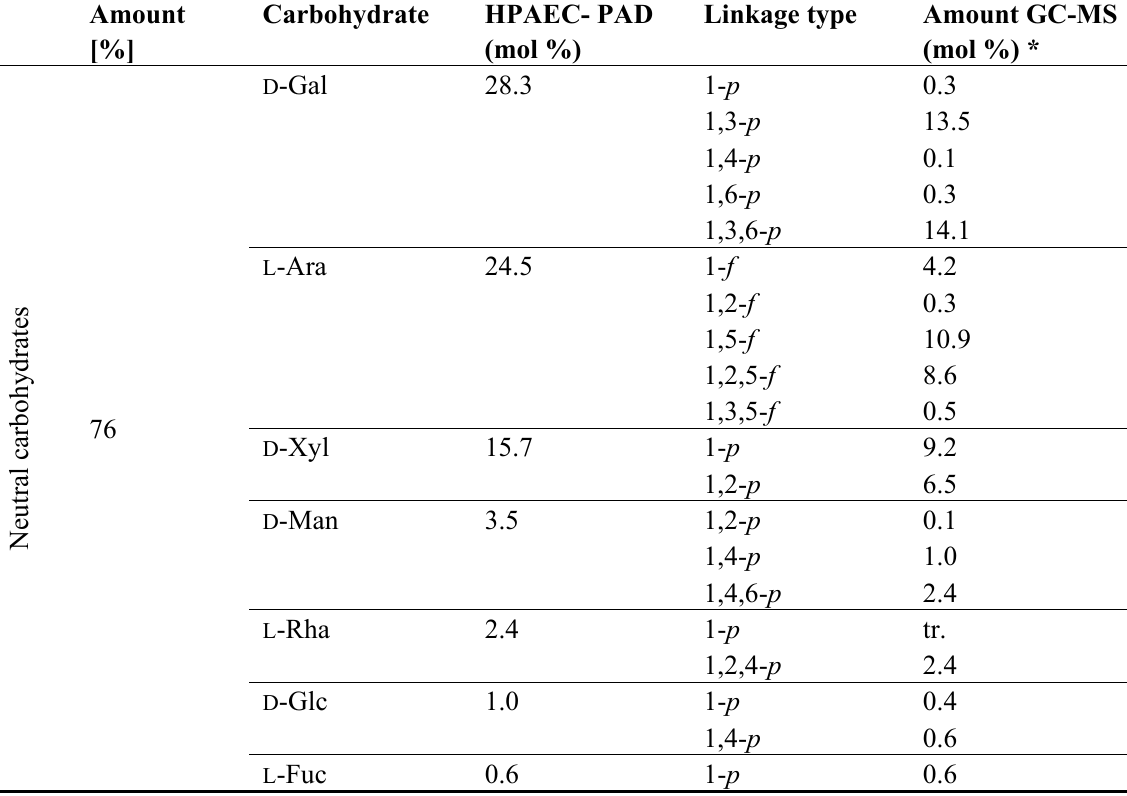
Table 1. Carbohydrate and protein composition (mol%) of F2 from R. nigrum : monosaccharide composition as determined by HPAEC-PAD after TFA hydrolysis, results of linkage analysis after methylation of carboxyl-reduced material and GC-MS identification; quantitative amino acid distribution in Y2 as determined by HPAEC-PAD (mol %). tr.: traces, n.d. = not